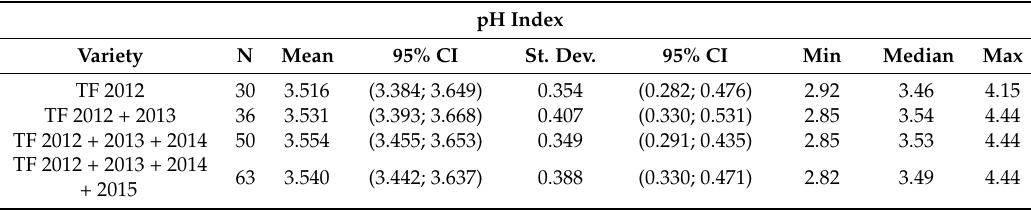
Table A8. Descriptive statistics of the samples used in the external test sets for the prediction of pH index.